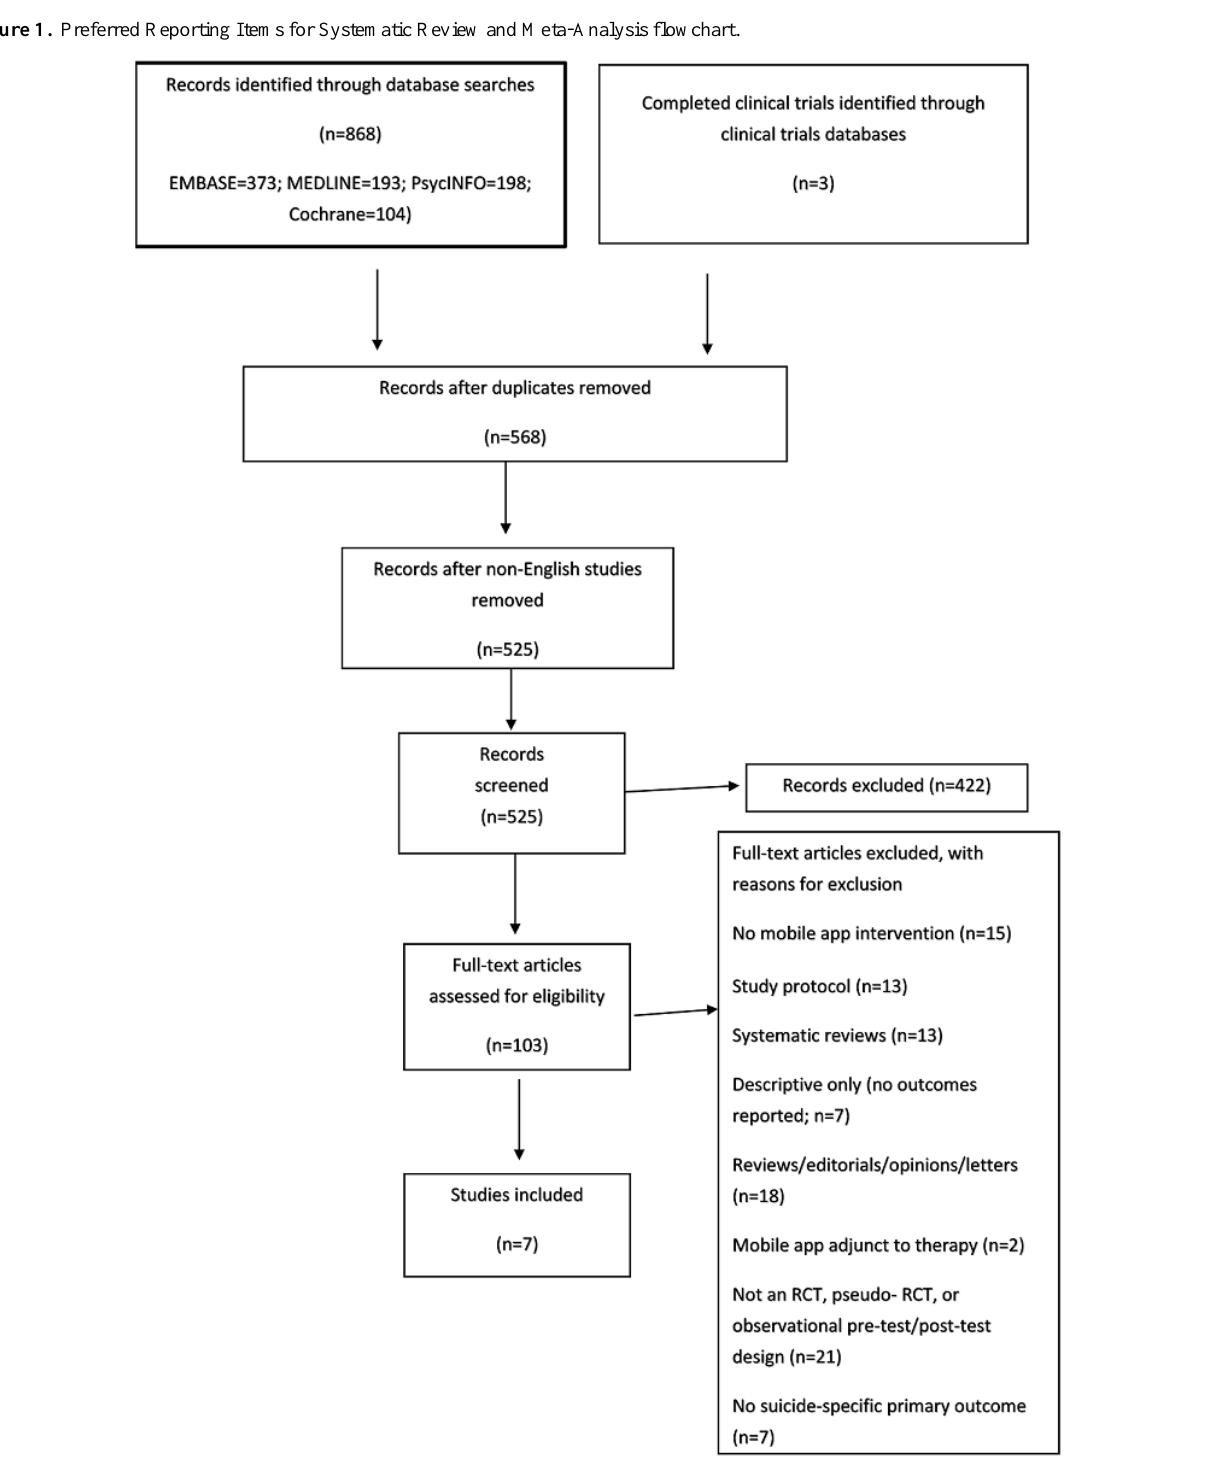
Figure 1. Preferred Reporting Items for Systematic Review and Meta-Analysis